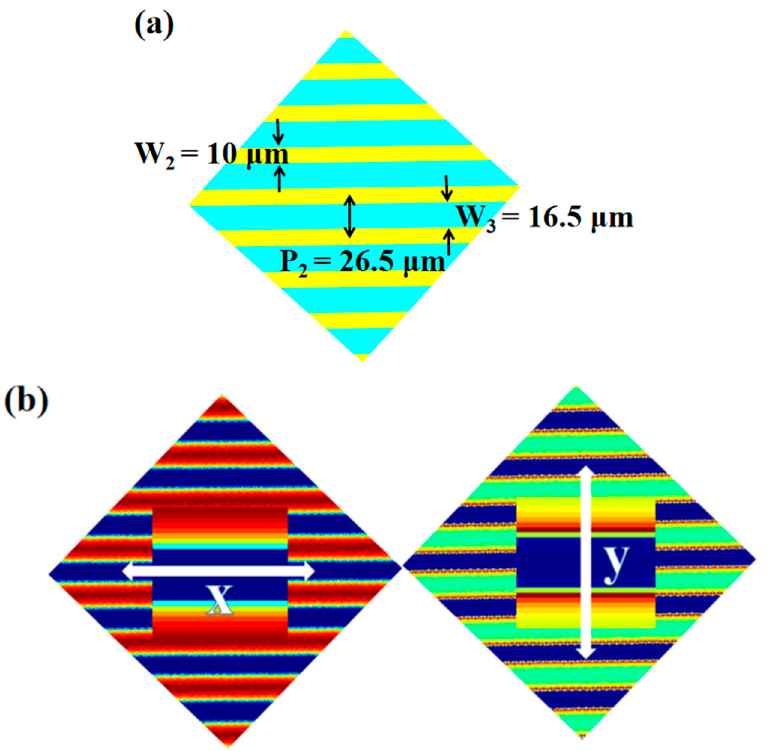
Figure 4. ( a ) Schematic diagram of the Cu grating. ( b ) Electric field of the Cu grating when the x- and y-polarized light is incident, respectively.